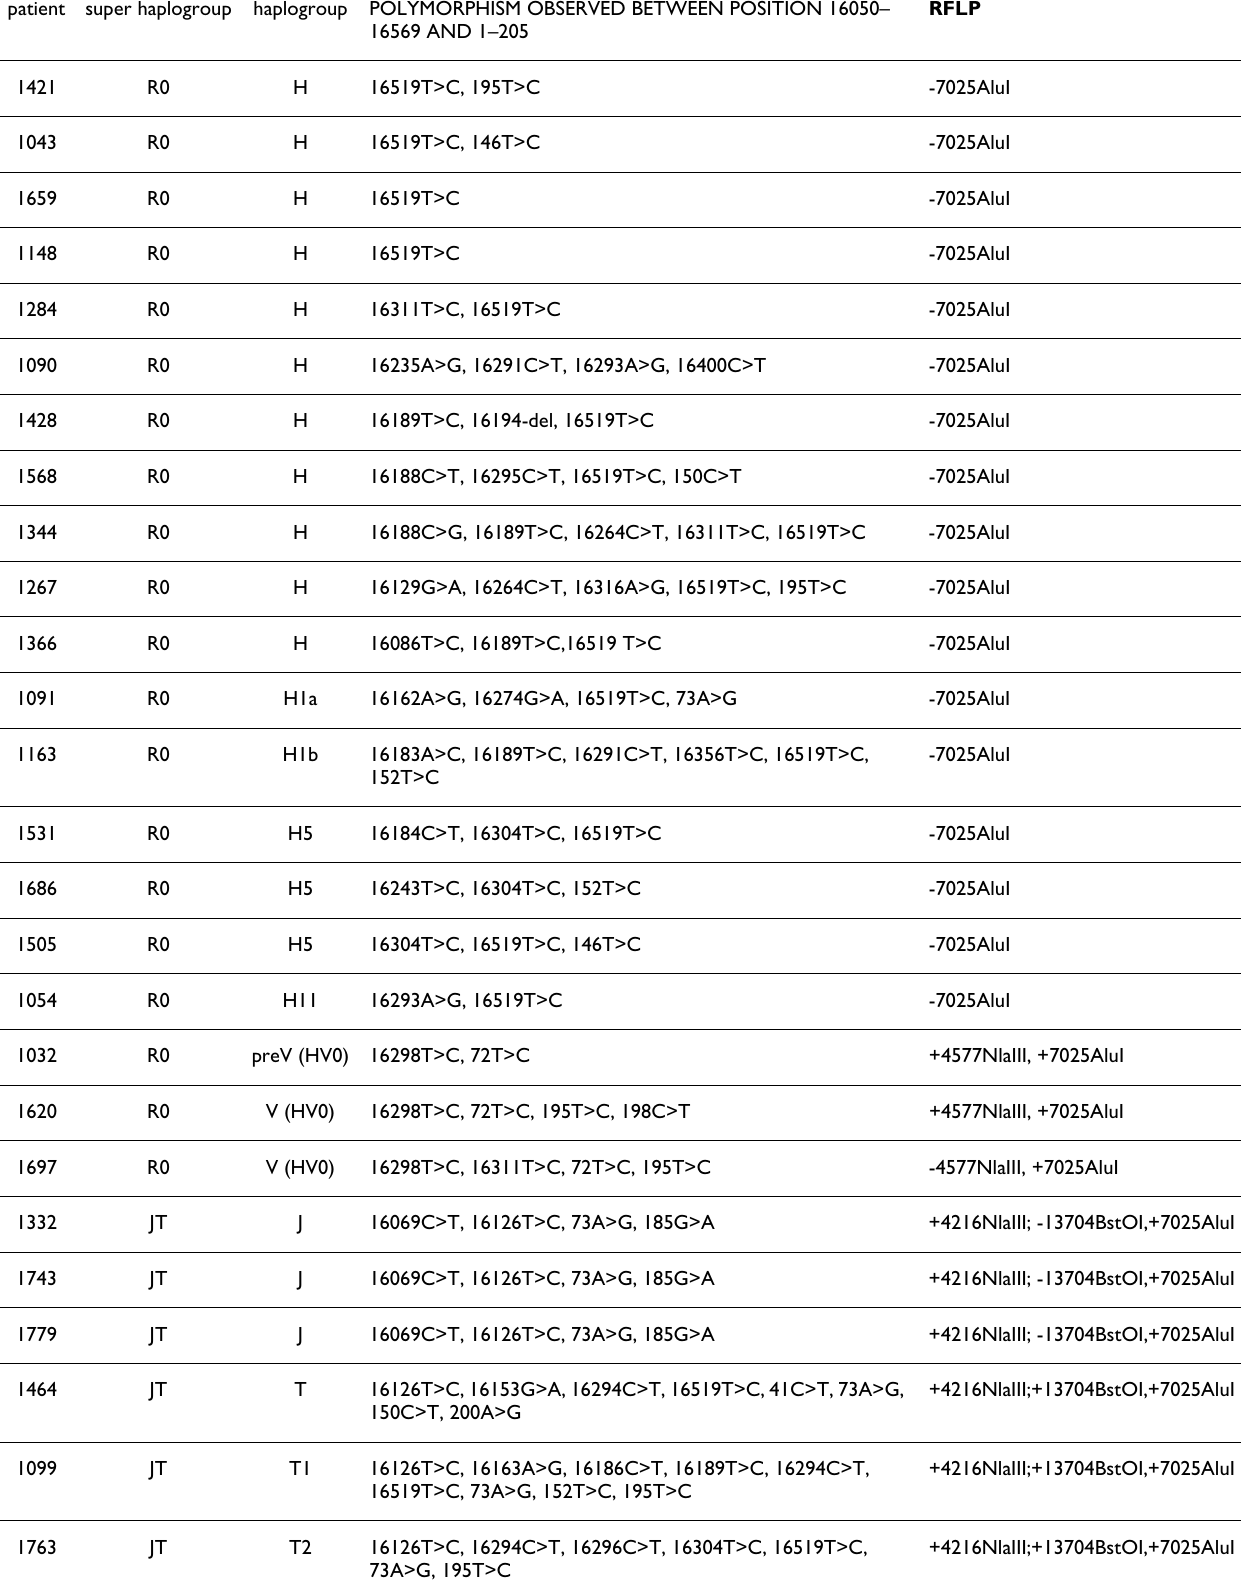
Table 1: RFLP and Control-Region mtDNA Haplotypes from the French OPA1 mutation carrier patient super haplogroup haplogroup POLYMORPHISM OBSERVED BETWEEN POSITION 16050– 16569 AND